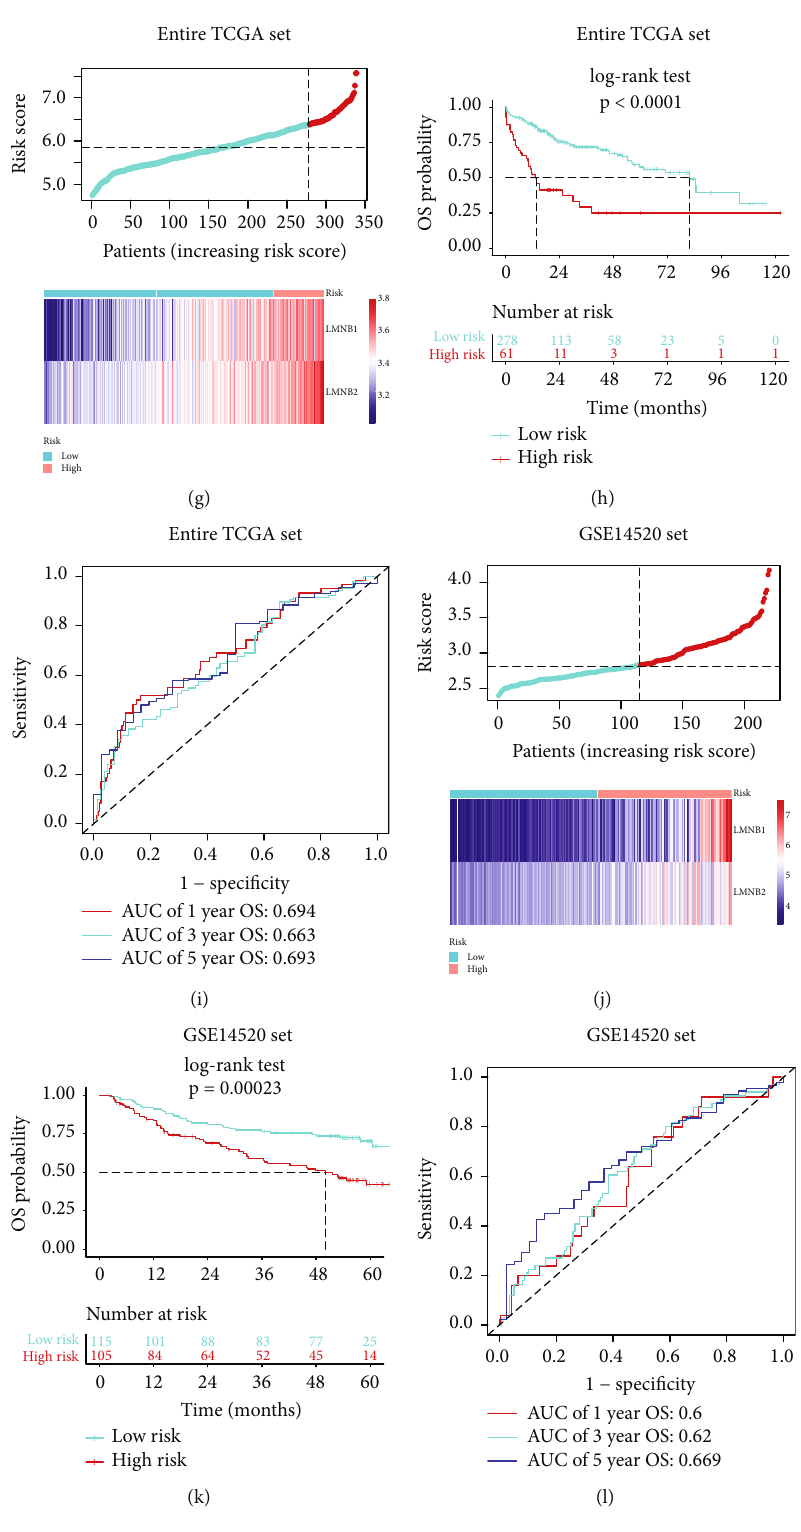
Figure 5: Construction and evaluation of the lamin family-based signature. (a, d, g, j) Risk score distribution of LMNB1 and LMNB2 in patients with di ff erent risk scores in the TCGA training set (a), TCGA test set (d), entire TCGA set (g), and GSE14520 set (j). (b, e, h, k) Kaplan-Meier survival analysis for HCC patients in the TCGA training set (b), TCGA test set (e), entire TCGA set (h), and GSE14520 set (k); log-rank test, all P < 0 : 0001 . (c, f, i, l). ROC curve analyses of the 1-year, 3-year, and 5-year overall survival of the lamin family- based signature from the TCGA training set ( AUC = 0 : 667, 0 : 702, 0 : 672 , respectively) (c), TCGA test set ( AUC = 0 : 713, 0 : 645, 0 : 71 , respectively) (f), entire TCGA set ( AUC = 0 : 694, 0 : 663, 0 : 693 , respectively) (i), and GSE14520 set ( AUC = 0 : 6, 0 : 62, 0 : 669 , respectively)